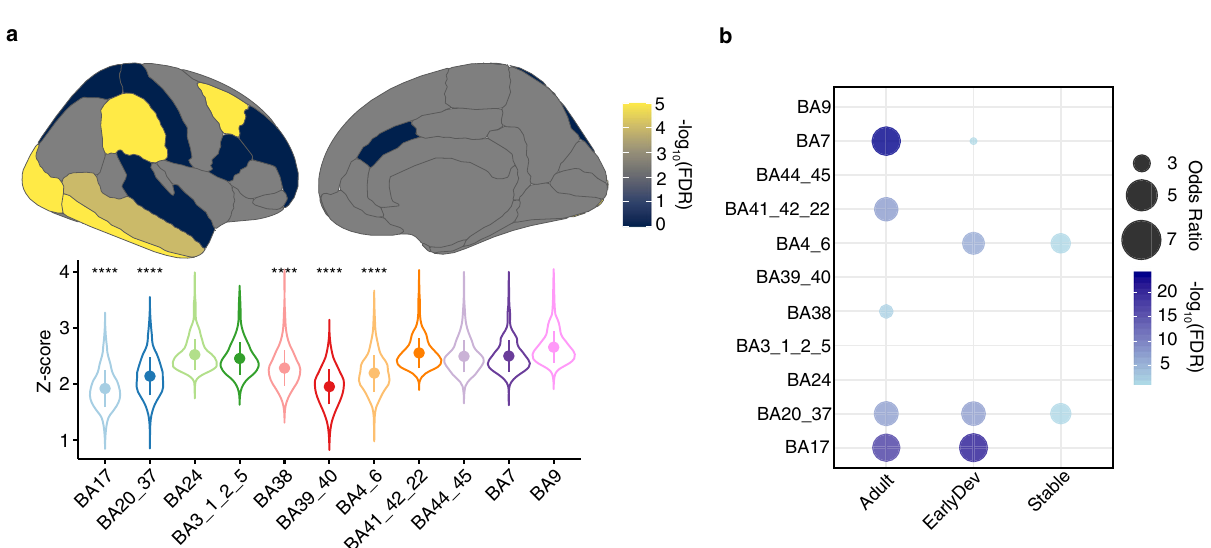
Fig. 5 Leave one region out (LoRo) analysis underscores the importance of speci fi c brain regions. a Brain visualizations and violin plots depicting the contribution of each ROI in the differential correlation after the speci fi c region was removed (LoRo). Brain visualizations represent the − log 10 (FDR) of the comparative analysis between ROIs after LoRo analysis (One-sided Wilcoxon ’ s rank sum test). Violins represent the Z-score ( Y -axis) of differential correlation after the speci fi c region ( X -axis) was removed. **** corresponds to a signi fi cant lower Z-score compared with other regions ( p < 0.001; One- sided Wilcoxon ’ s rank sum test). Dots represent the mean Z-score for the speci fi c Brodmann area. Lines represent the standard deviation (SD). N = 415 genes from independent analysis. Exact P -value: BA17 p < 2e − 16 , BA20_37 p < 2e − 16 , BA38 p = 6.8e − 05 , BA39_40 p < 2e − 16 , BA4_6 p < 2e − 16 . b Bubblechart with − log 10 (FDR) and Odds Ratio from Fisher ’ s Exact test representing enrichment between developmental groups and genes differentially expressed in each region. X -axis shows abbreviations for each region. Y-axis represents each developmental cluster identi fi